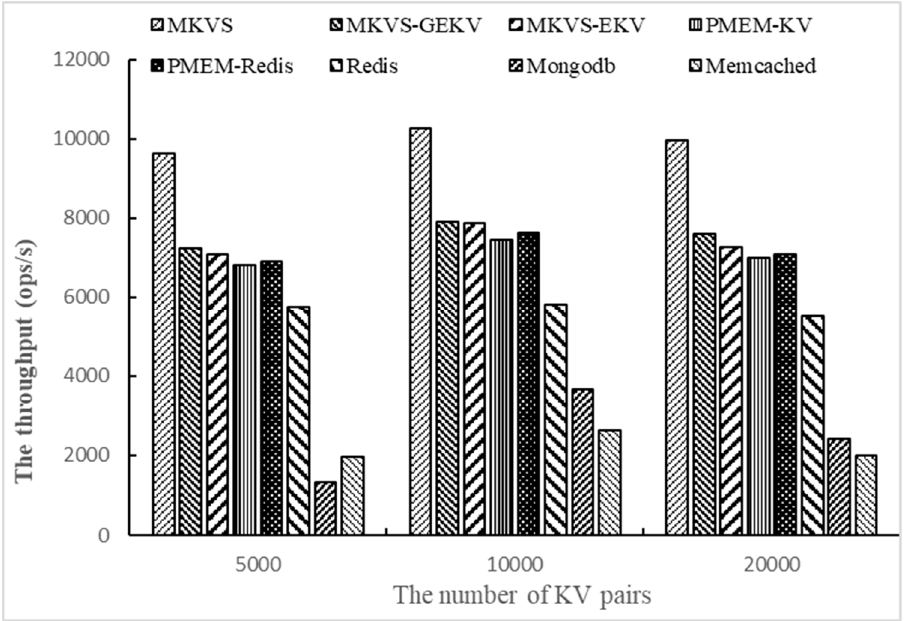
Figure 5. The throughput of changing the number of KV pairs with Workloada.